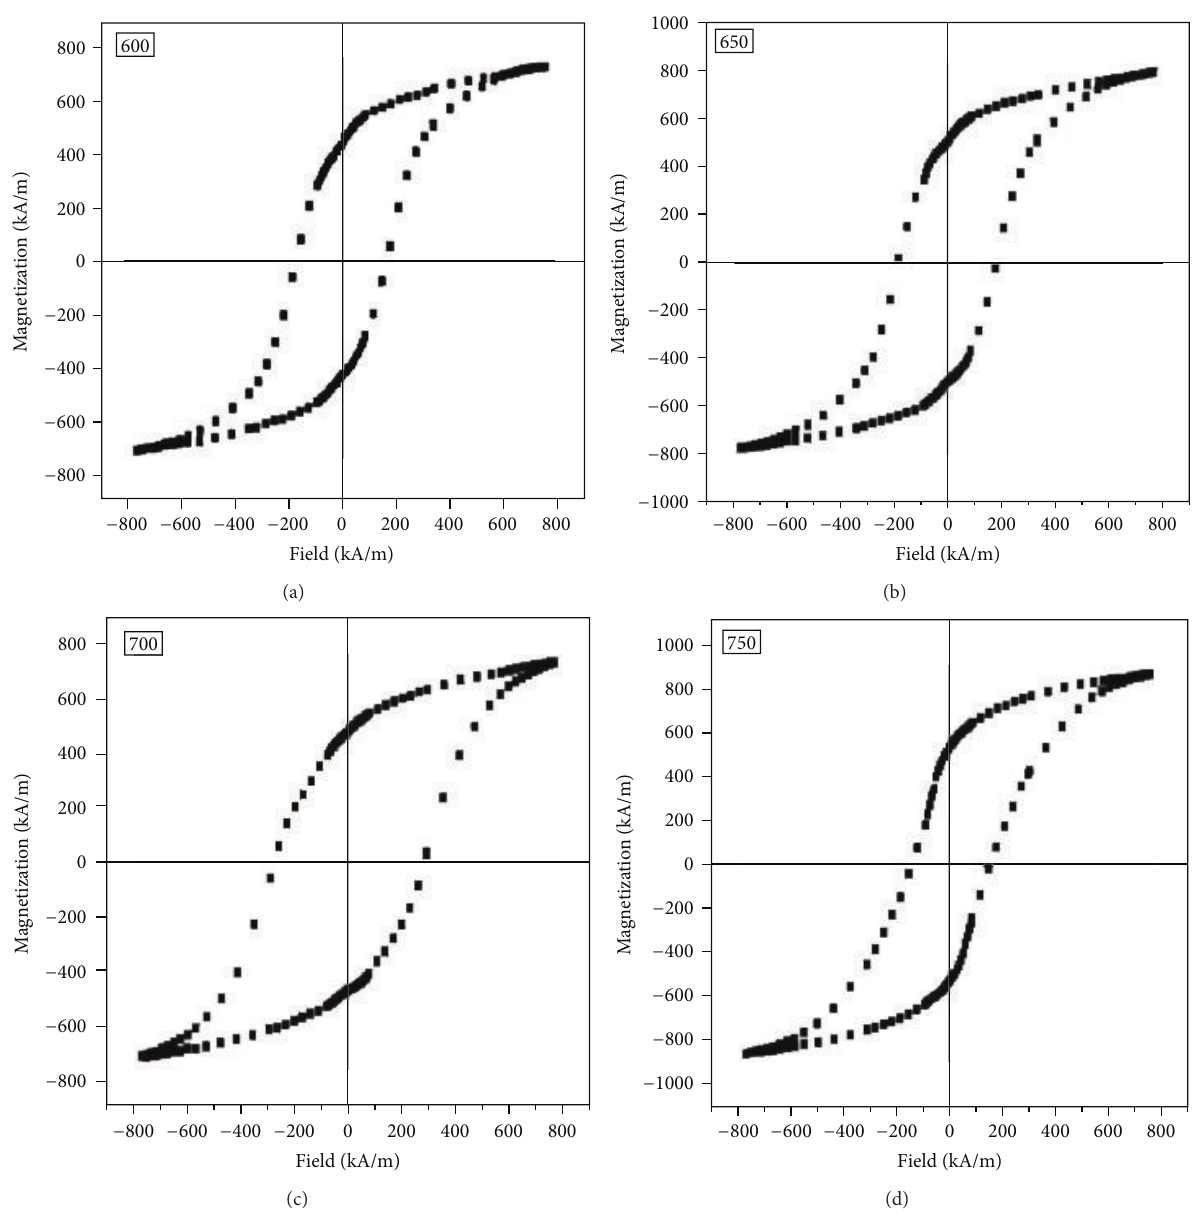
Figure 6: Hysteresis loops of Nd 9.4 Pr 0.6 Fe 74.5 Co 6 B 6 Ga 0.5 Ti 1.5 C 1.5 annealed ribbon at different annealing temperature for 10